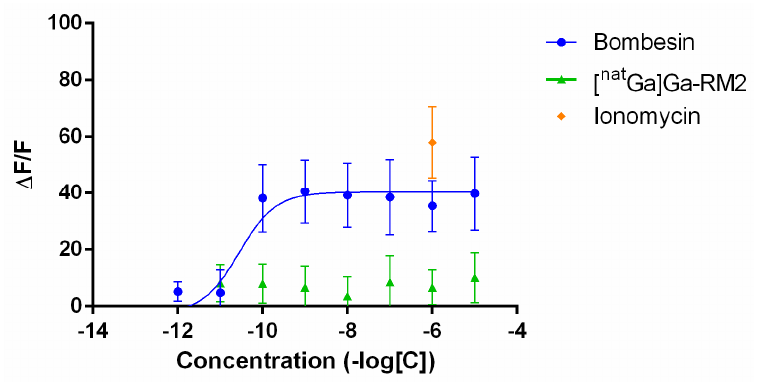
Figure 6. Intracellular calcium release induced in PC-3 cells by bombesin, [ nat Ga]Ga-RM2 and ionomycin. Results are shown as the difference between the peak value reached after peptide injection and the basal value divided by medium basal fluorescence ( Δ F/F).